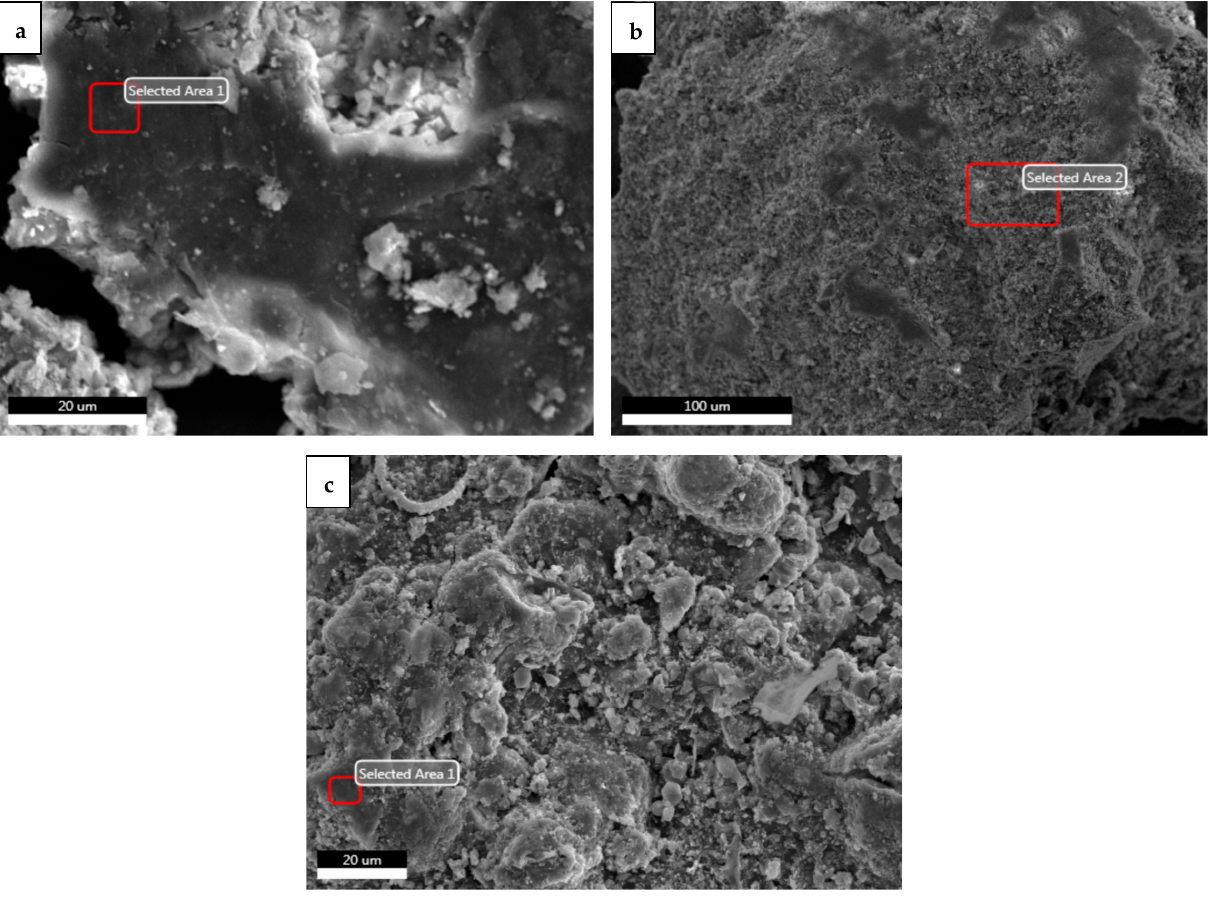
Figure 6. SEM images in which the areas where EDS analyses were performed are highlighted. ( a ) Red pigment of Sample 1; ( b ) black pigment of Sample 2; ( c ) green pigment of Sample 3. Table 2. Elemental composition of the pigments.